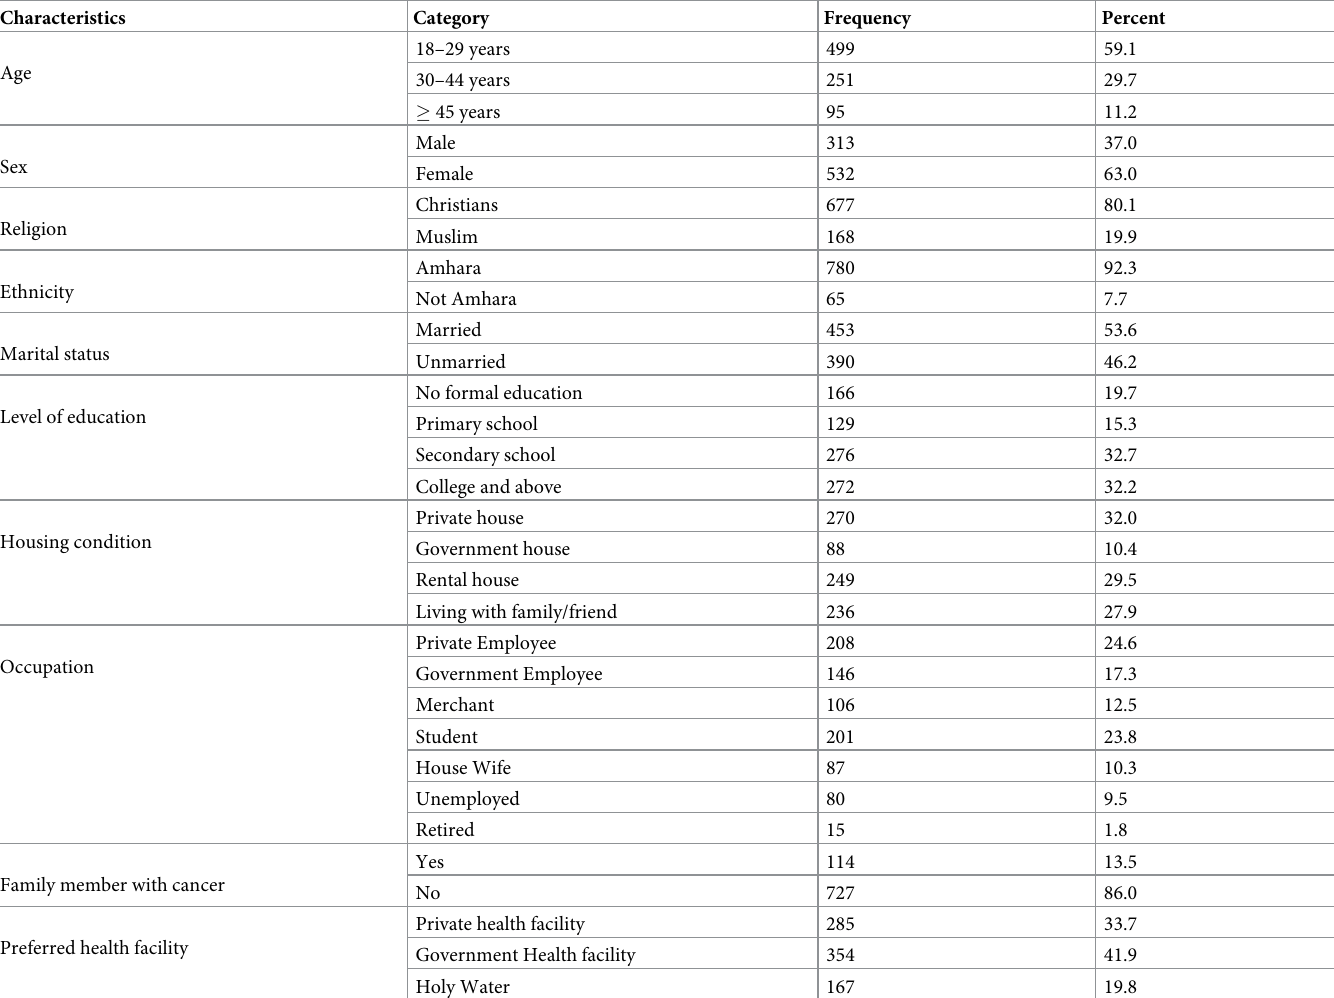
Table 1. Sociodemographic characteristics of the respondents, Bahir Dar city residents, North West Ethiopia, 2019 (n = 845). Characteristics